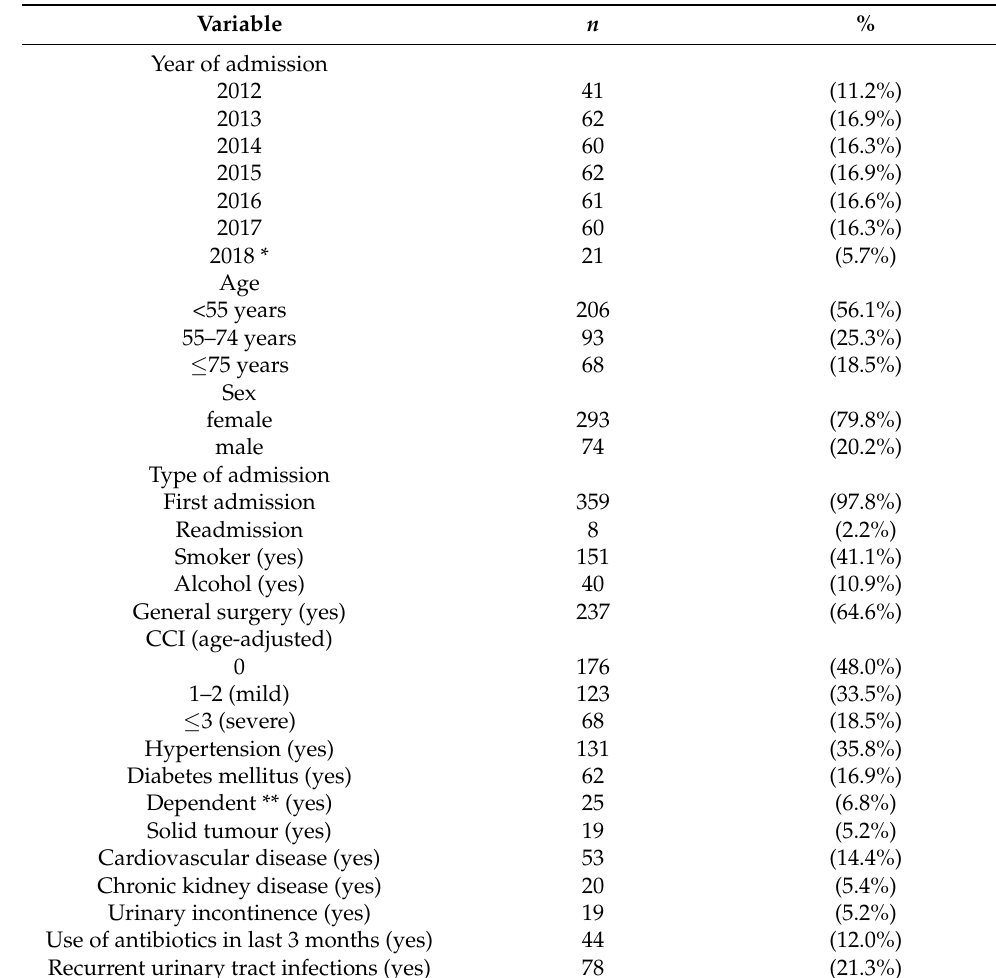
Table 1. Baseline characteristics of patients included in the study.